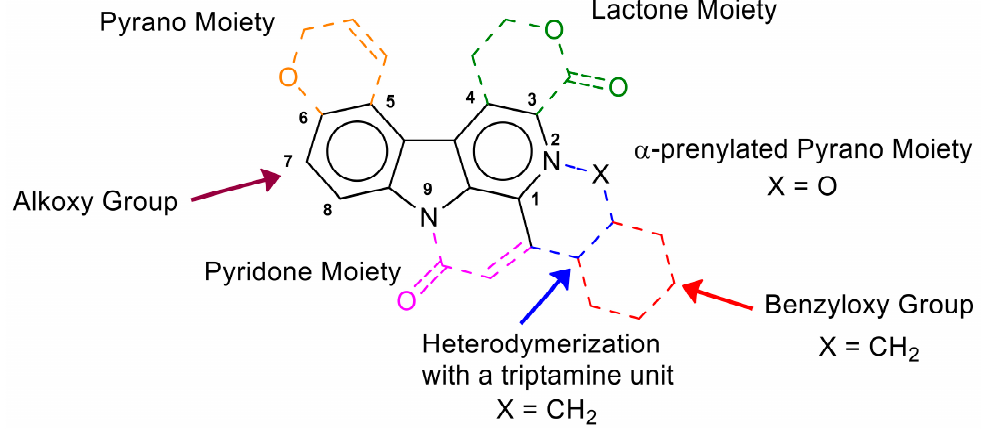
Figure 3. Beneficial modifications of the indole alkaloids-based skeleton.